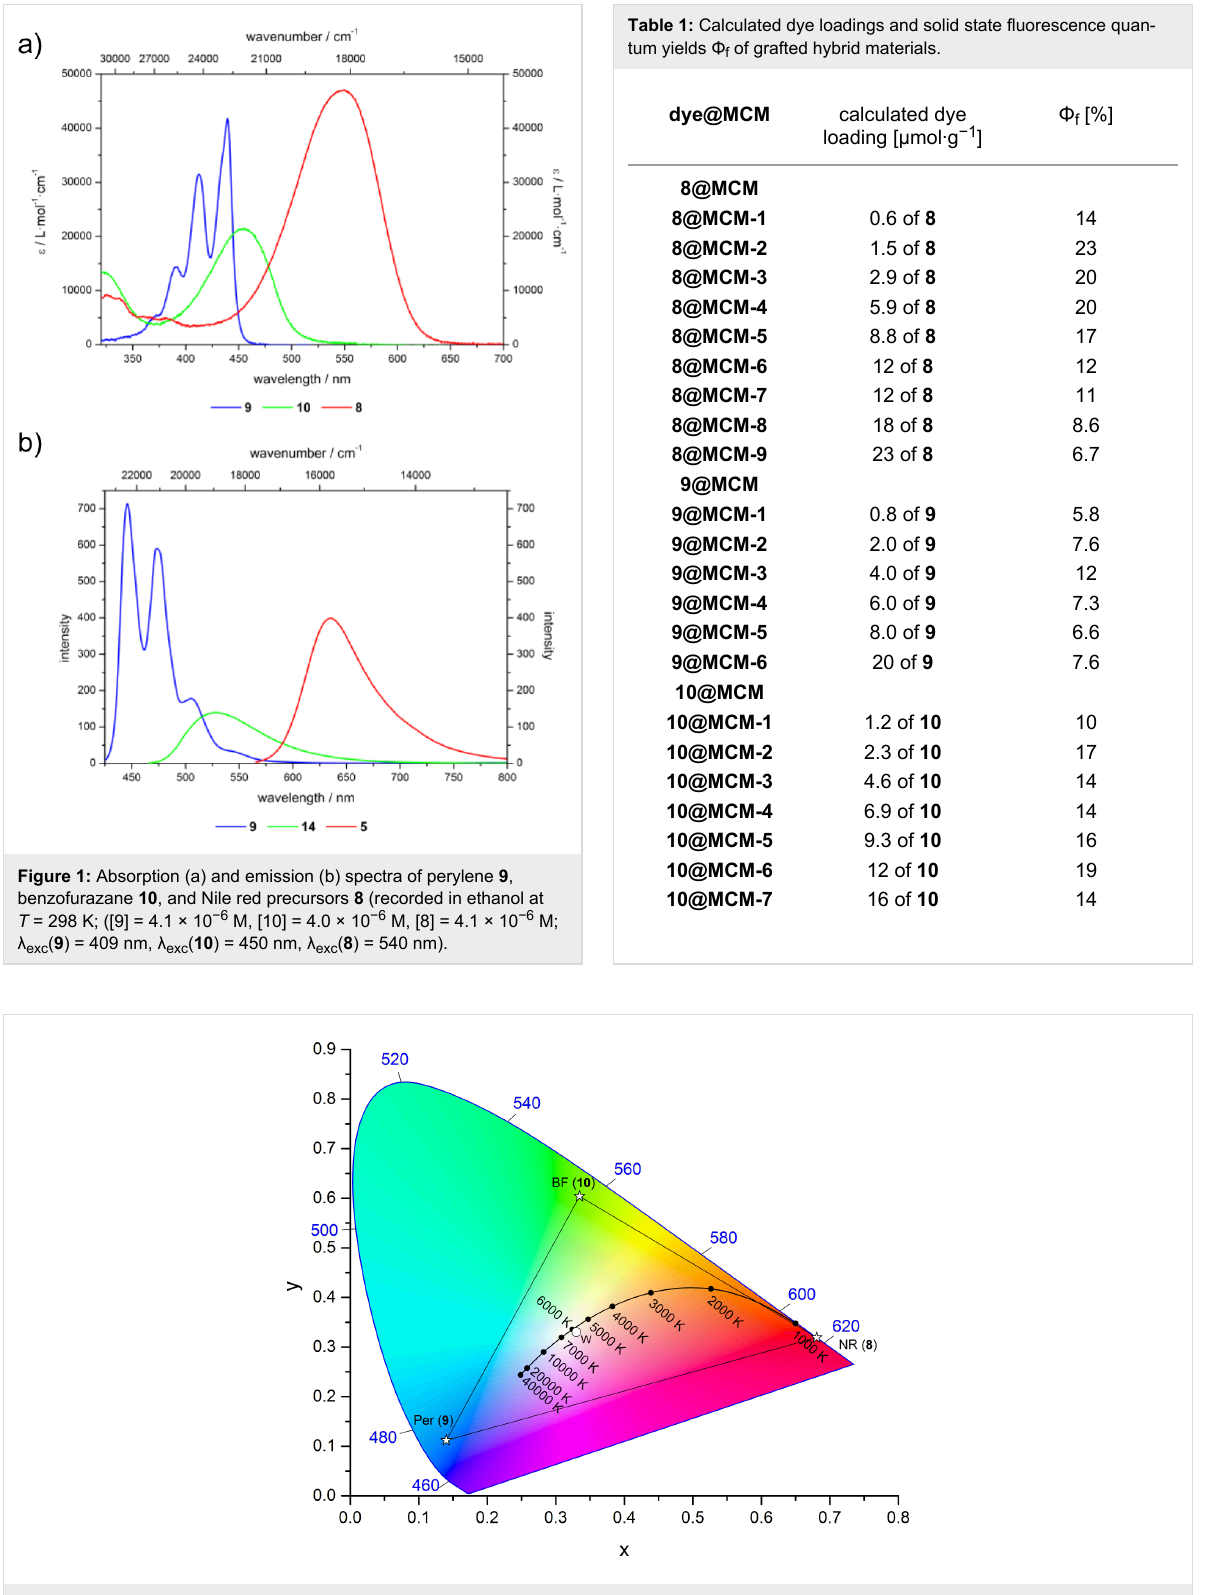
Figure 2: CIE 1931 color space chromaticity diagram (2° observer) with the CIE chromaticity coordinates of the emitting precursors 9 (blue), 10 (green), and 8 (red) in ethanol as well as the color space accessible by mixing these three precursors shown as triangle.